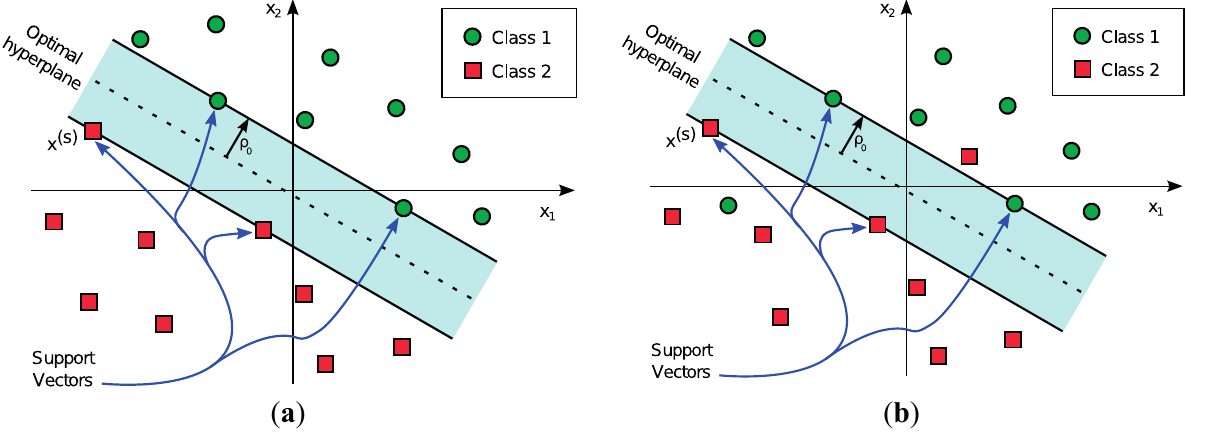
Figure 1. Representation of a Support Vector Machine (SVM)) classifier corresponding to ( a ) a linearly separable pattern, where the hyperplane totally separates green circles from red squares; and ( b ) a non-linearly separable pattern, where no hyperplane separates all the green circles from the red